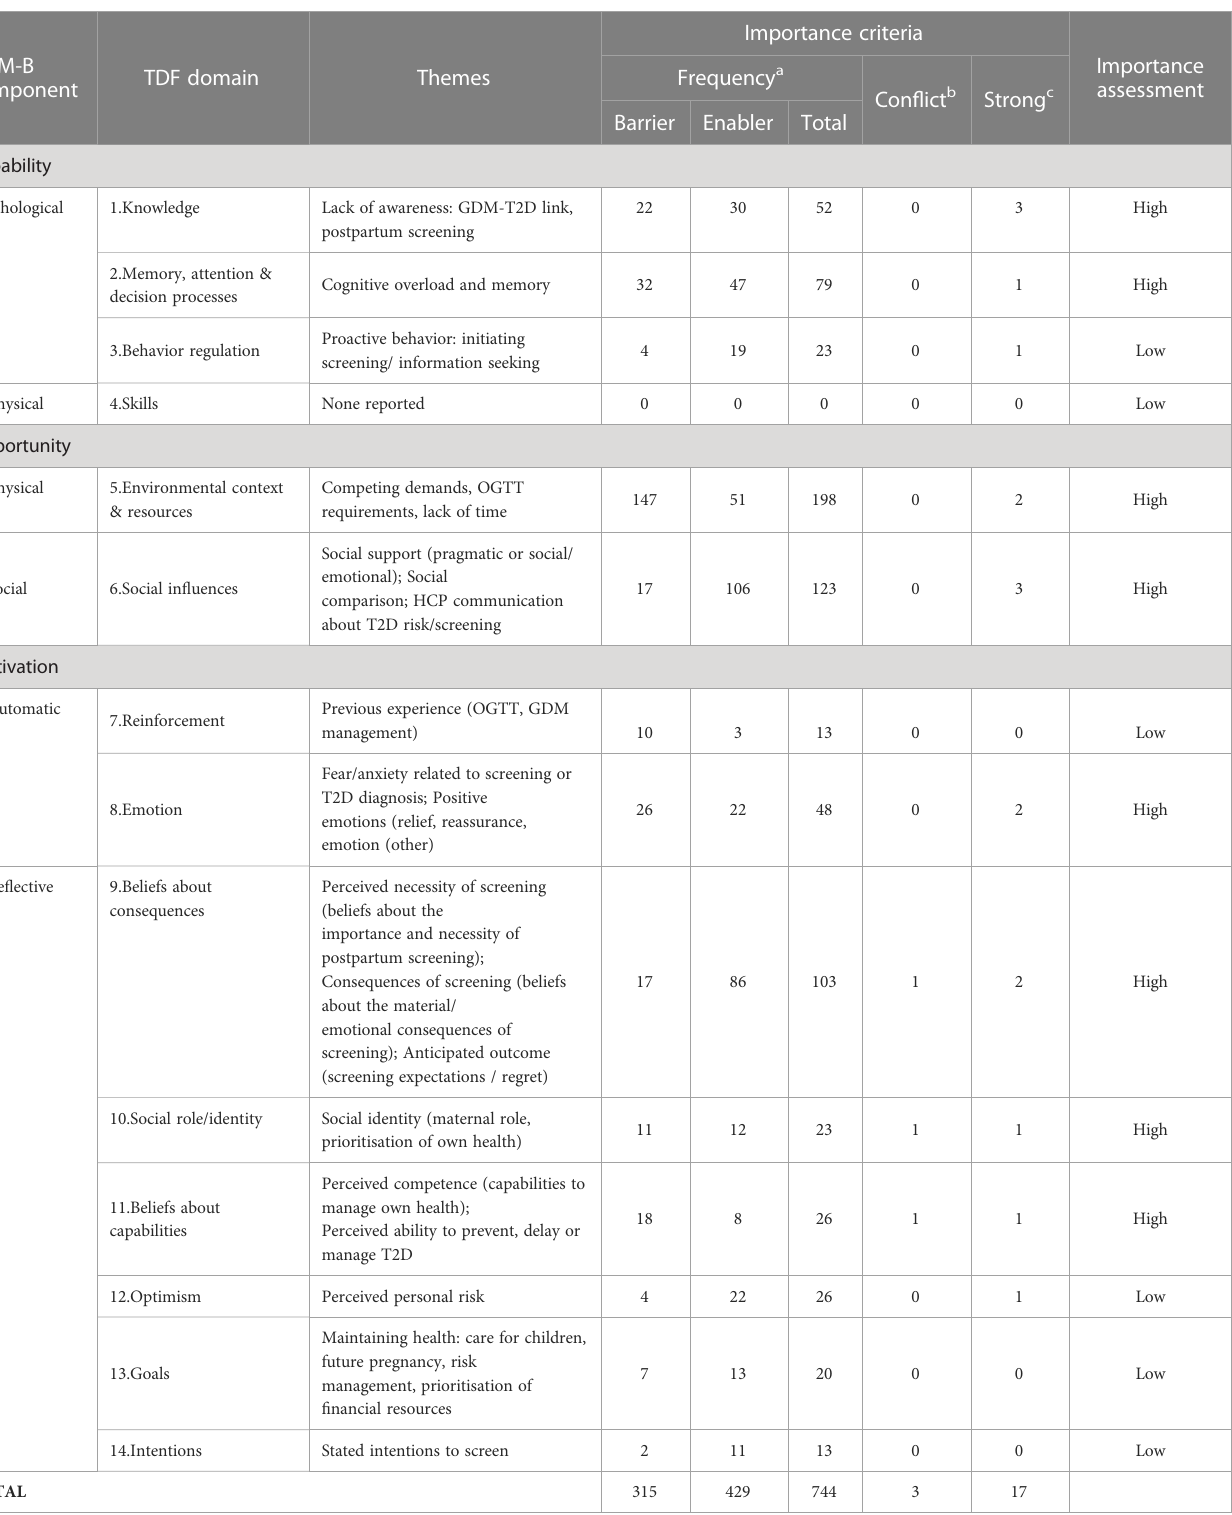
TABLE 2 Identi fi cation of important TDF domains (key themes and importance criteria).